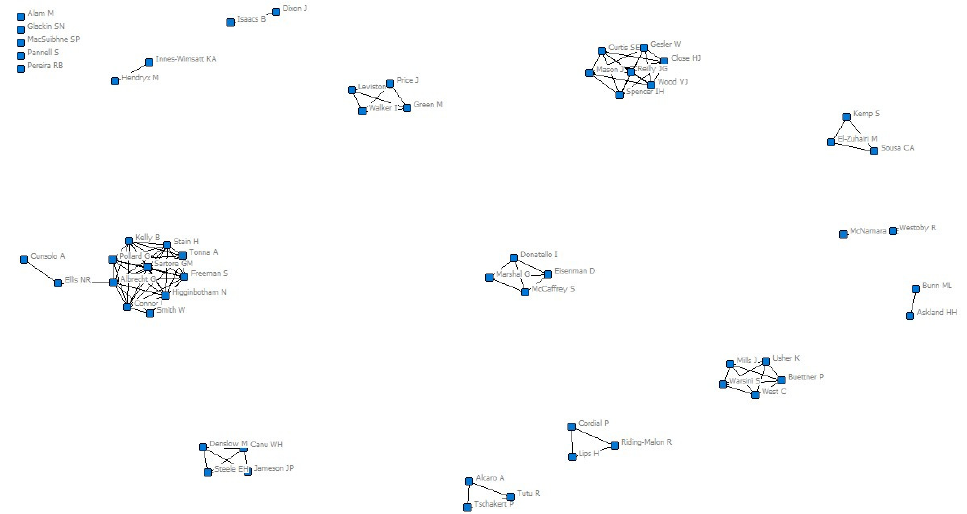
Figure 1. Coauthors’ network of solastalgia.